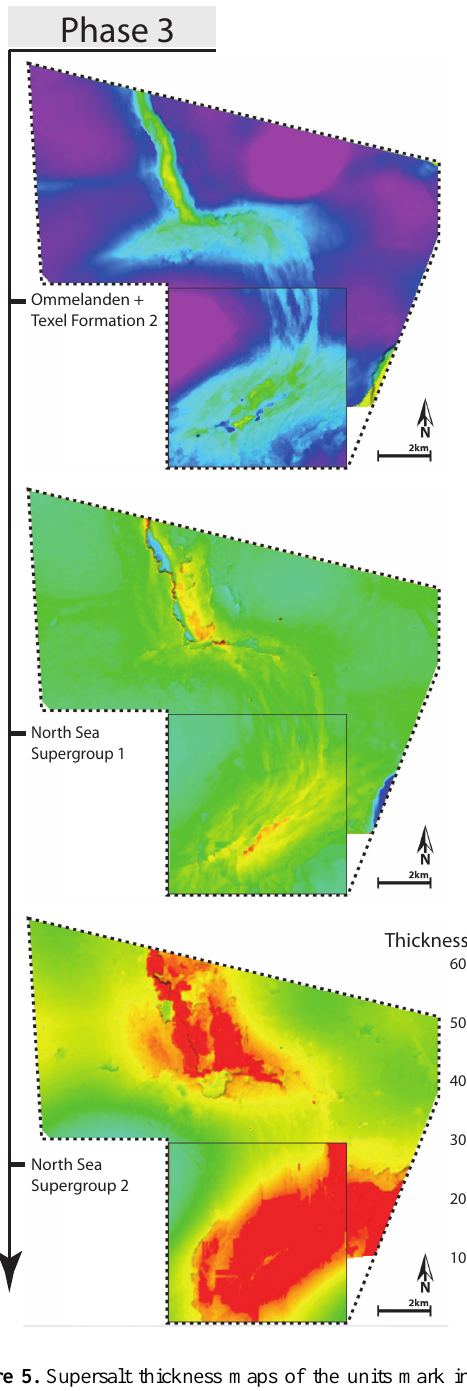
Figure 5. Supersalt thickness maps of the units mark in the pro- file at the bottom. Due to the influence of faults in the supersalt the thickness information in the center of the pillows is faulty. The dotted line in the chalk indicates the change from phase 2 to phase 3 (Fig. 5b). The thickness maps show substantial thickening above the basins in phase 1 and 3 (Fig. 5b) and constant thicknesses in phase